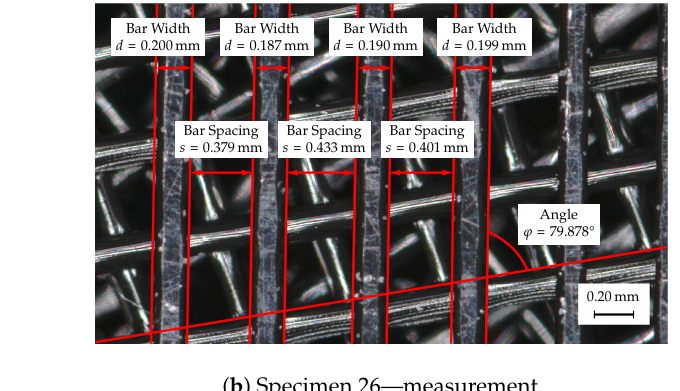
Figure 19. Actual-target comparison of specimen 26 with the Keyence VR5200 3D surface profilometer. ( a ) shows specimen 26 without measurement lines at 80 × magnification. ( b ) shows specimen 26 with measurement lines and only slight deviations in the actual-target comparison